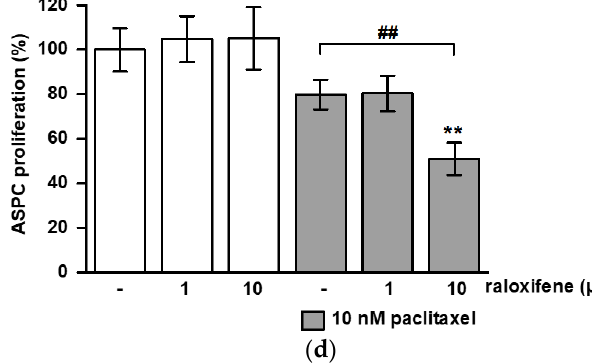
Figure 1. Synergistic and additive effects of raloxifene and paclitaxel on cell viability and proliferation. L3.6pl and ASPC cells were treated with different concentrations of raloxifene and paclitaxel alone or in combination. The graphs show the results obtained from MTT and BrdU assays on ( a ) cell viability in L3.6pl, ( b ) cell viability in ASPC, ( c ) proliferation in L3.6pl and ( d ) proliferation in ASPC. The data are given as mean values ± SEM from at least two independent experiments; the mean control value was set to 100%. * p < 0.05, ** p < 0.01 and *** p < 0.001 versus control; ## p < 0.01 and ### p < 0.001 versus paclitaxel.